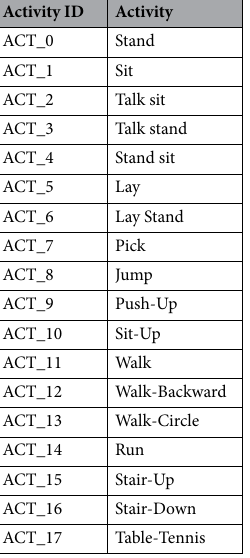
Table 3. A tabular representation of the classes of human activities performed in the KU-HAR dataset.